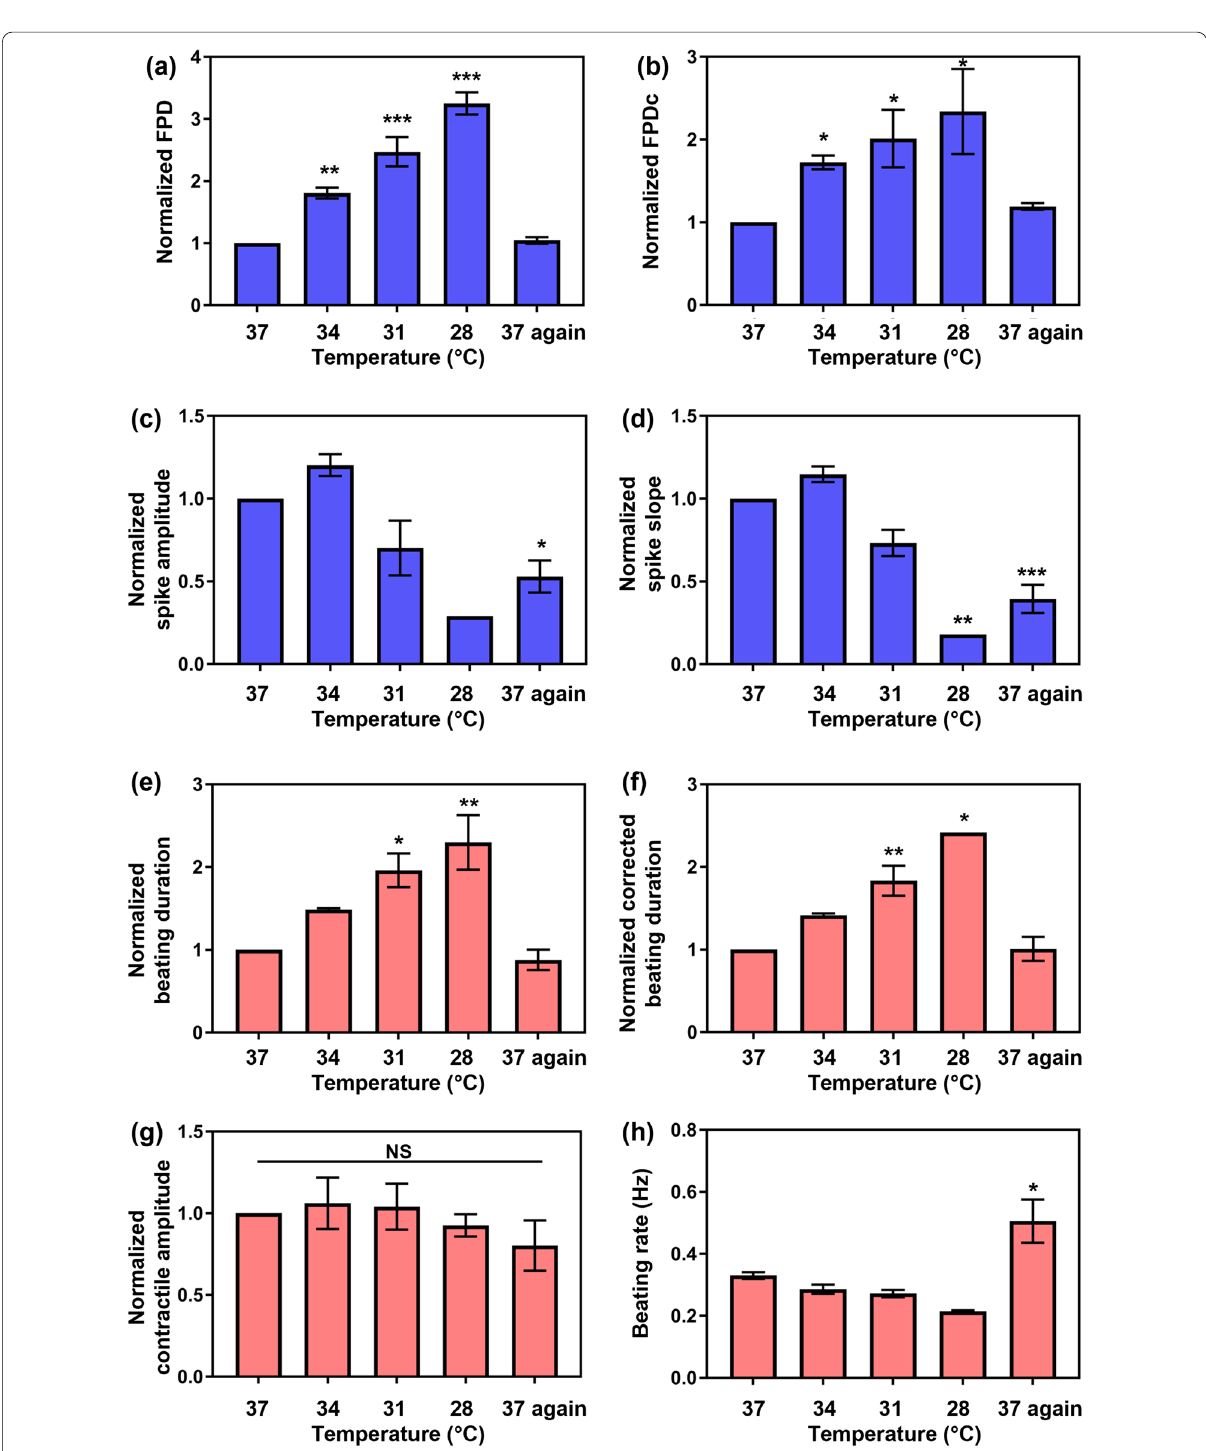
Fig. 5 Analysis of field potential and contractility parameters with respect to temperature (37 °C, 34 °C, 31 °C, 28 °C and raised back to 37 °C). a Normalized FPD, b normalized corrected FPD (FPDc), c normalized spike amplitude, d normalized spike slope, e normalized beating duration, f normalized corrected beating duration, g normalized contractile amplitude h beating rate. Corrected duration interval) (1/3) . n 5 biologically independent samples. Statistical significance of data was determined with the help of one‑way ANOVA followed by = Tukey’s honest significant difference test, with significant differences defined by *p < 0.05, **p < 0.001 and